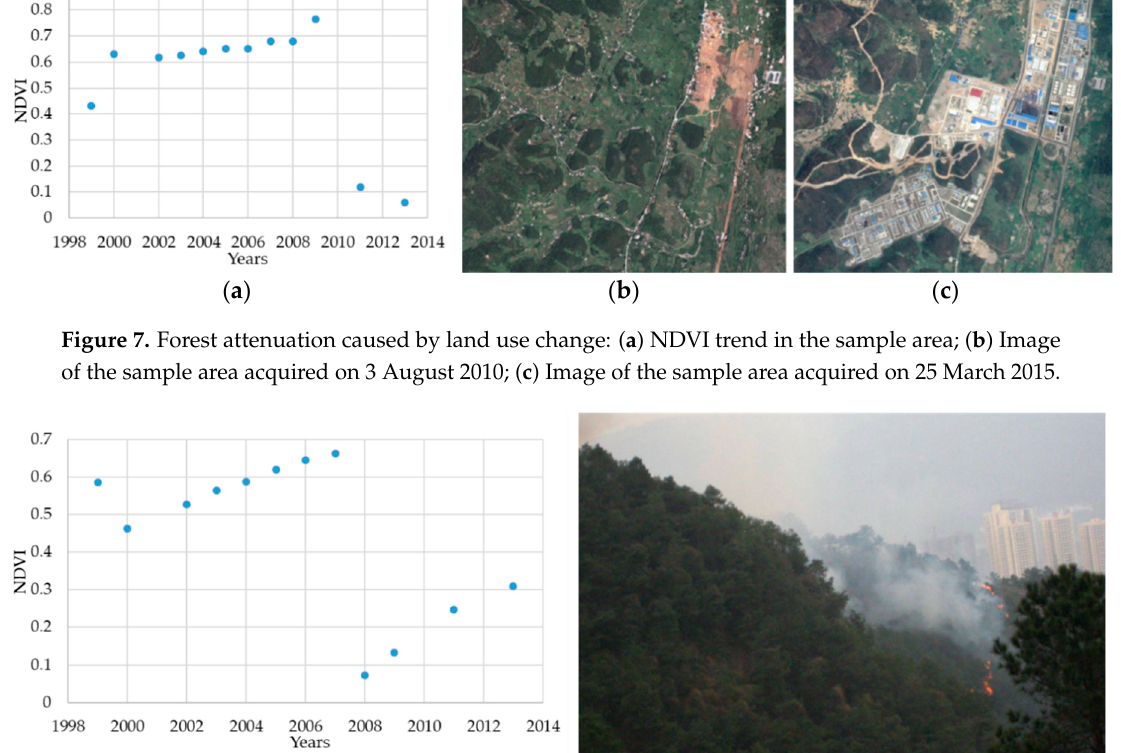
Table 4. Trend detection accuracy.